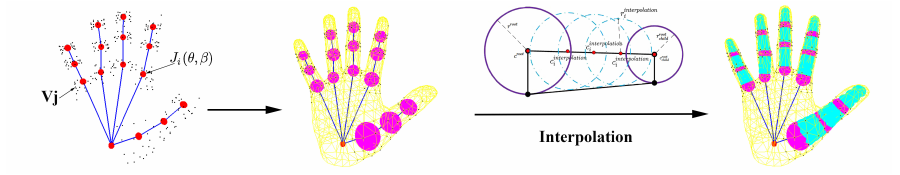
Figure 13. The process of generating a set of collision spheres to approximate the volume of the fingers in MANO hand